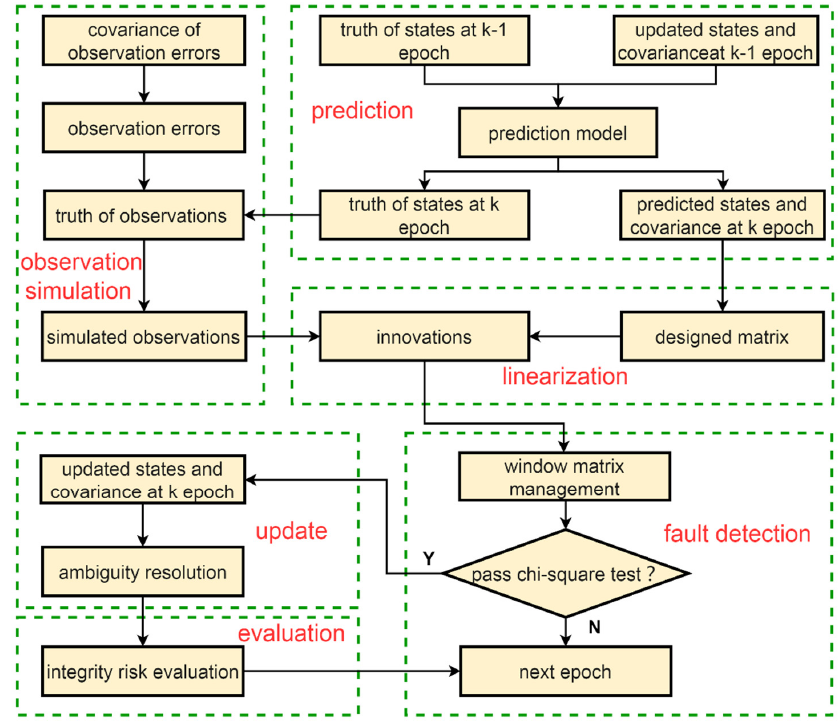
Figure 1. The simulation process for the simulated dynamic PPP. Table 1. Configuration of the parameters for the simulated PPP and integrity risk evaluation.